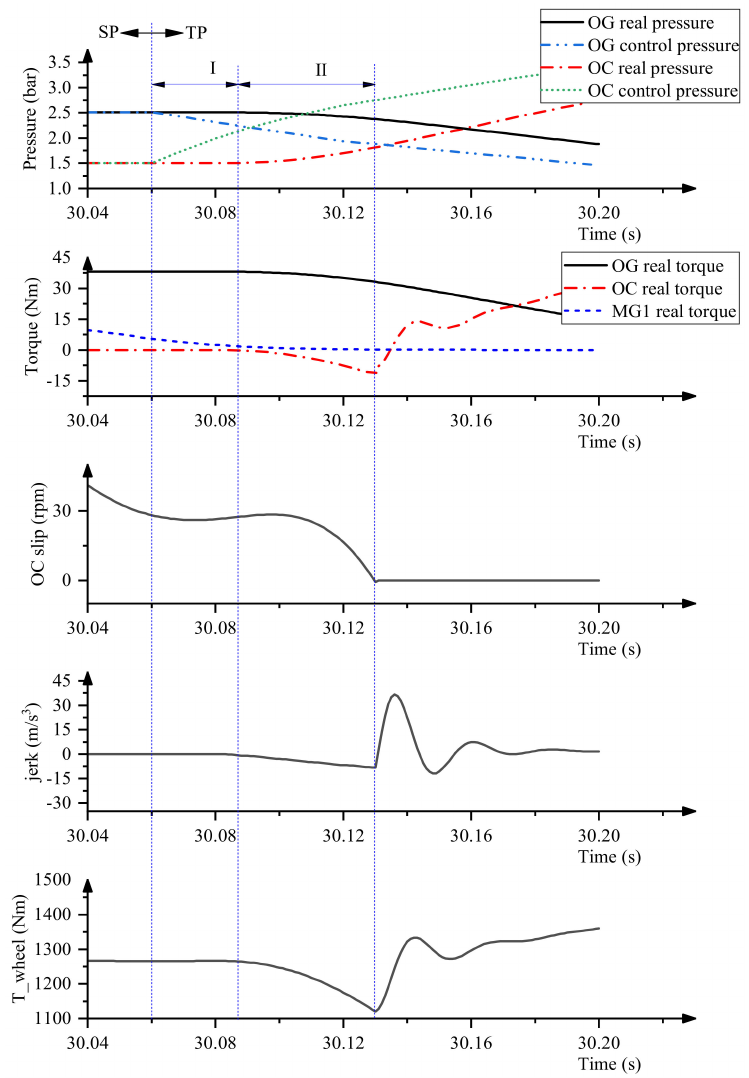
Figure 9. Simulation results near the maximum